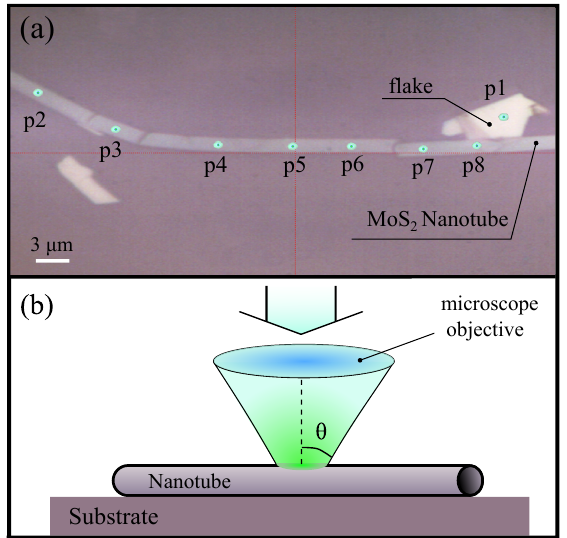
Figure 1. ( a ) Image of a MoS 2 nanotube (NT) taken inside the micro-photoluminescence (micro-PL) setup. The NT has few cracks that are not essential for our experiment. Green dots indicate spots where the micro-PL was measured. ( b ) Schematic of NT excitation at micro-PL measurement (not to scale). As shown, the lens collects the emission at angles θ (cid:46)